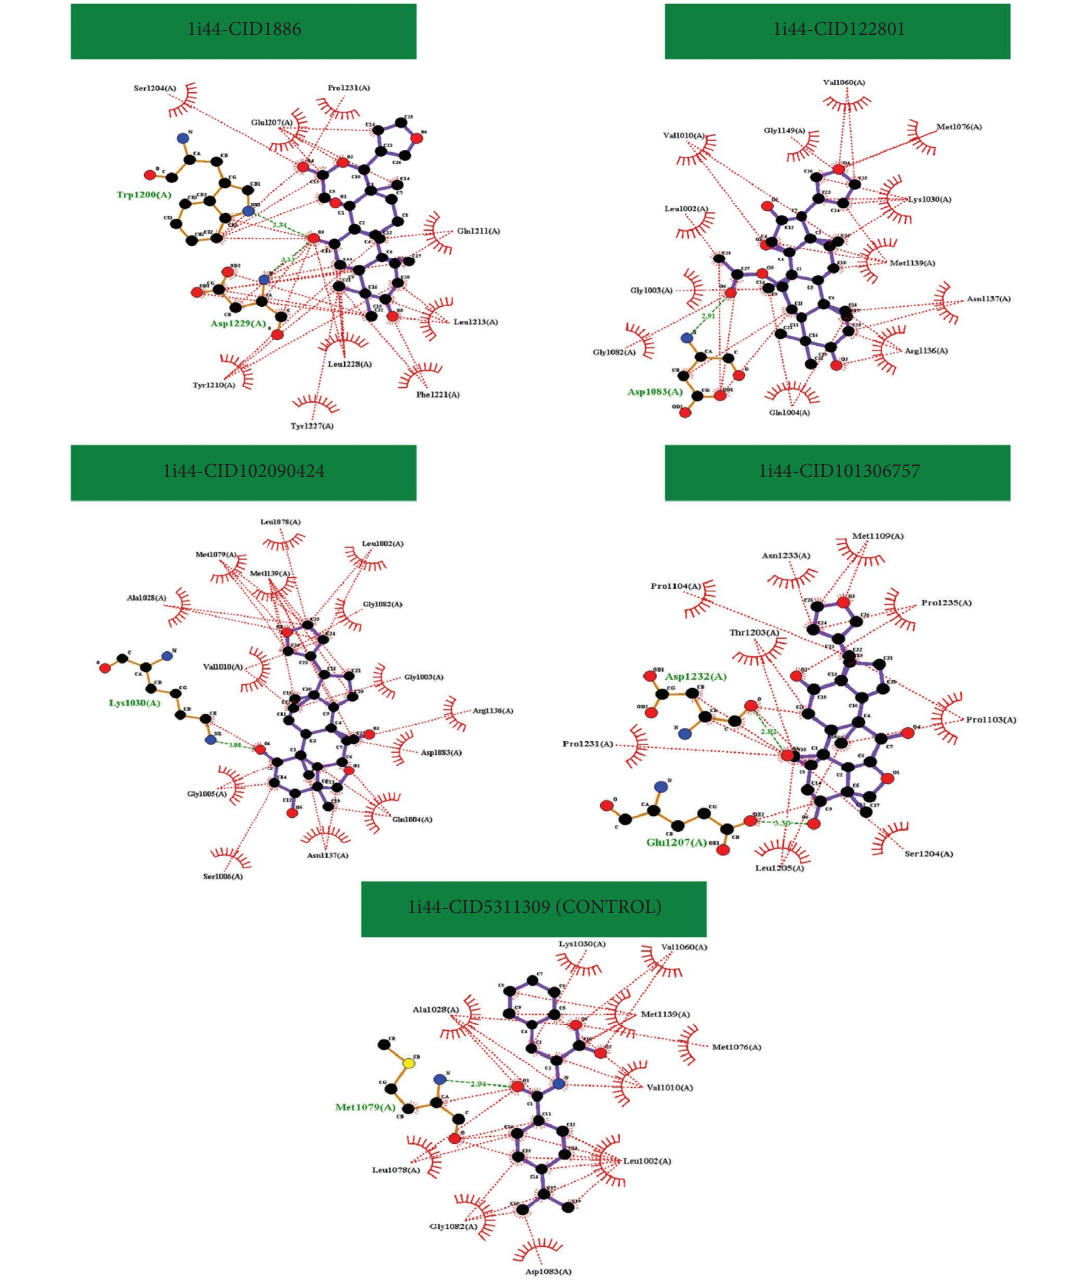
Figure 1: Interaction between the insulin receptor ectodomain (PDB 1I44) with compound CID 1886, CID 122801, CID 102090424, and CID